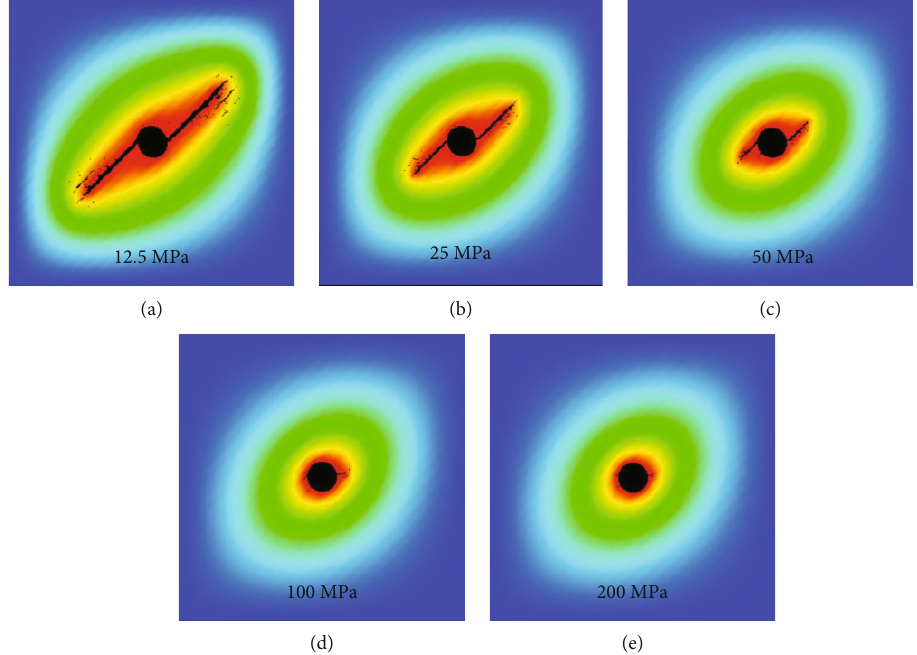
Figure 14: E ff ects of BP compressive strengths on HF length ( step = 101 , pore water pressure is 55 MPa).